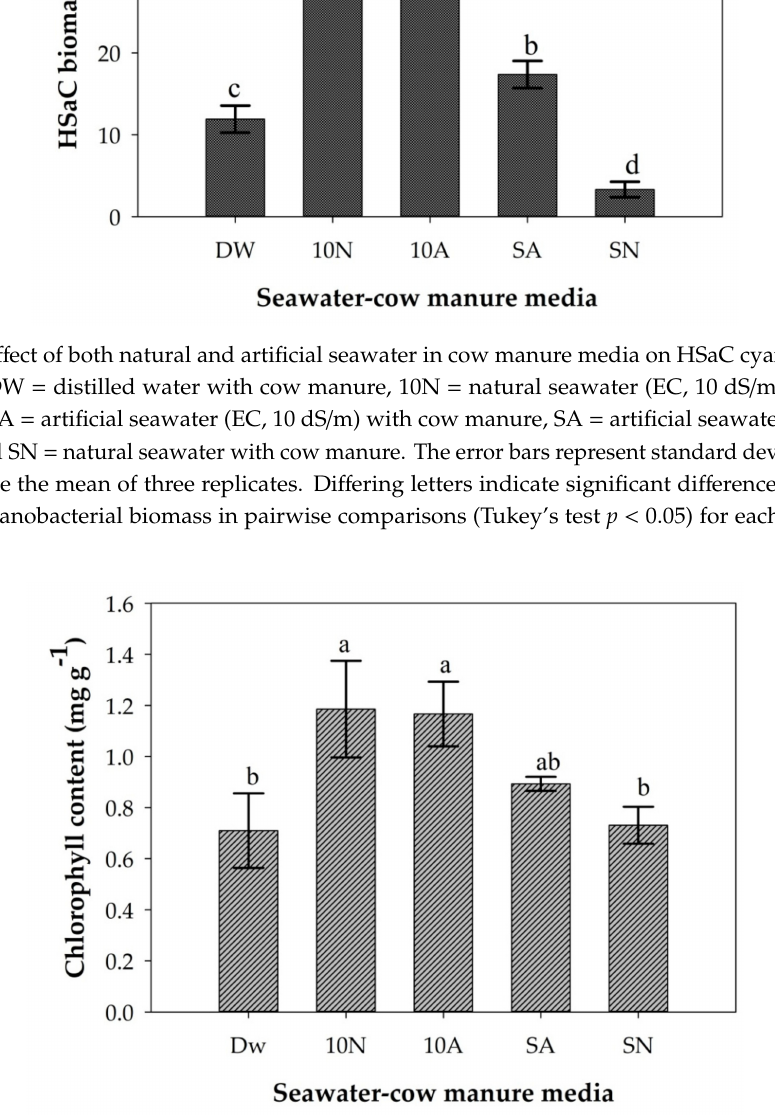
Figure 7. E ff ect of natural and artificial seawater with cow manure on the chlorophyll content of salt-tolerant cyanobacteria (HSaC). DW = distilled water with cow manure, 10N = natural seawater (EC, 10 dS / m) with cow manure, 10A = artificial seawater (EC, 10 dS / m) with cow manure, SA = artificial seawater with cow manure and SN = natural seawater with cow manure. The error bars represent standard deviations (SDs). The data are the mean of three replicates. Di ff ering letters indicate significant di ff erences in means of HSaC cyanobacterial chlorophyll content in pair wise comparisons (Tukey’s test p < 0.05) for each treatment by